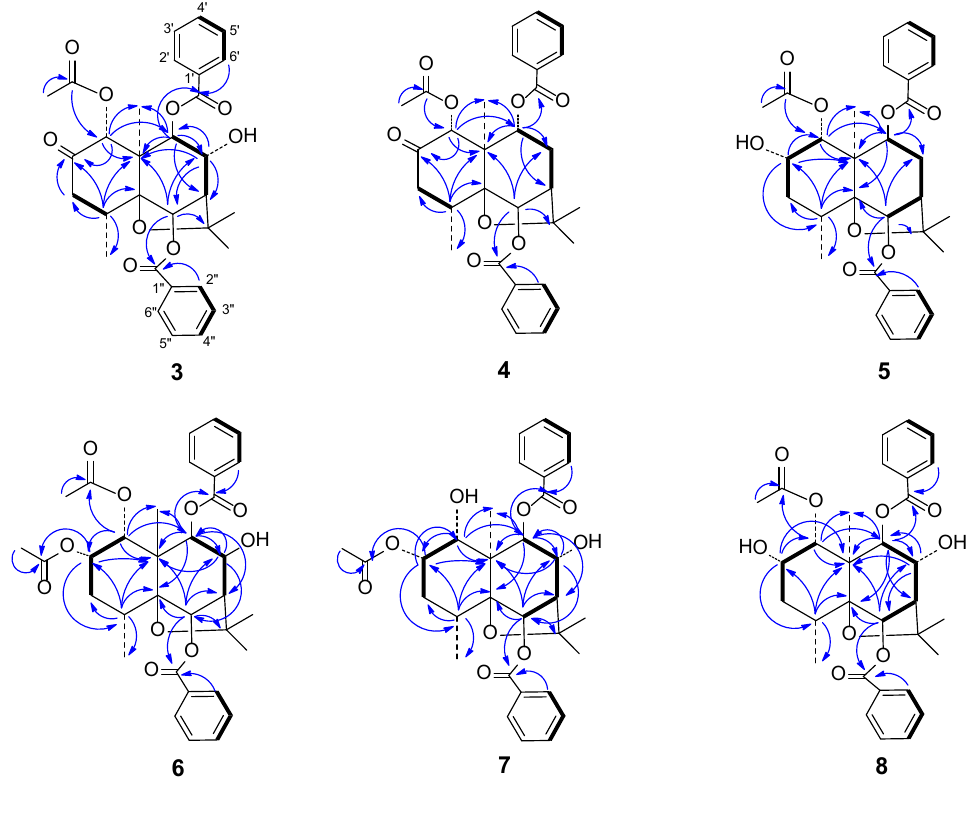
Figure 3. Main 1 H– 13 C long-range correlation (→) and 1 H- 1 H correlation ( – ) signals in the HMBC and COSY spectra of 3 – 8